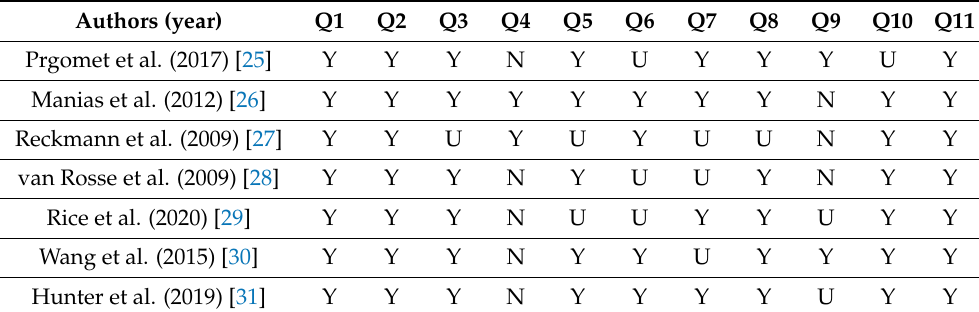
Table 7. Quality assessment of systematic reviews included.